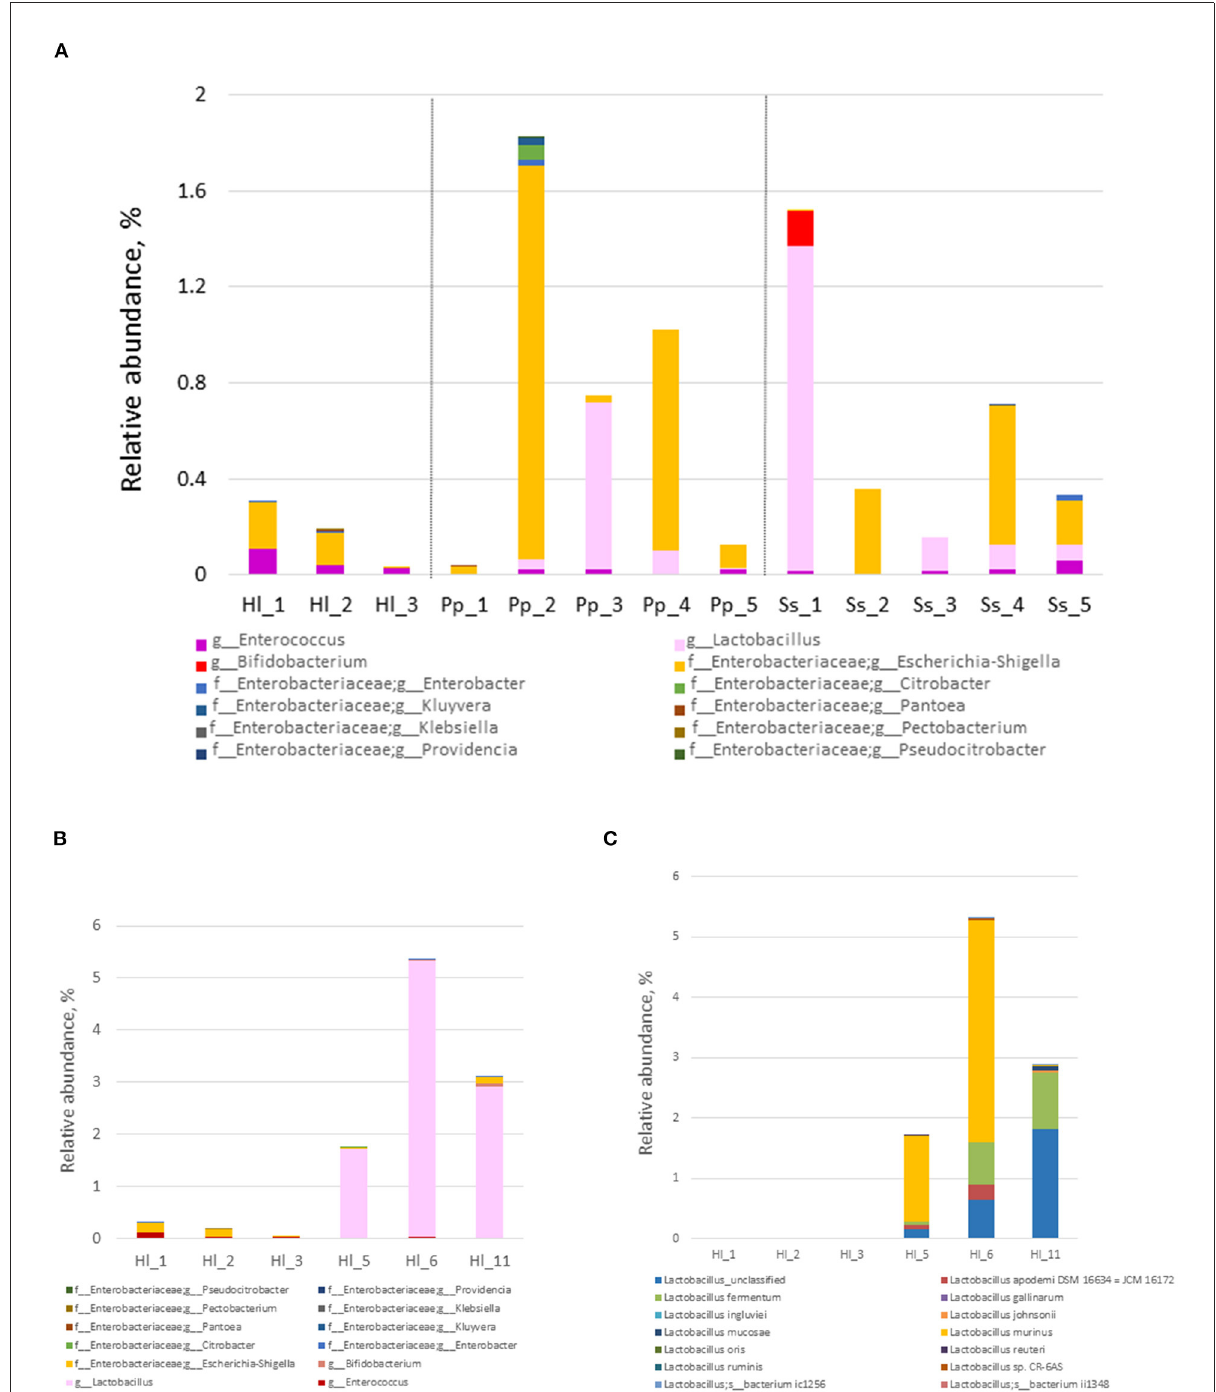
FIGURE4 Composition and abundance of probiotics and commensal gut bacteria. (A) Relative abundance of commensal gut bacteria at the genus level in the fecal samples of cohorts inhabiting the rainforest area. White-handed gibbons (Hl, n = 3), Bornean orangutans (Pp, n = 5), and siamangs (Ss, n = 5). (B) Relative abundance of commensal gut bacteria at the genus level in Hl housed in the rainforest area or the conservation area. (C) Species of the genus Lactobacillus and their abundance in Hl inhabiting the rainforest area or the conservation area. Rainforest area: Hl1, Hl2, and Hl3; conservation area: Hl5, Hl6, and